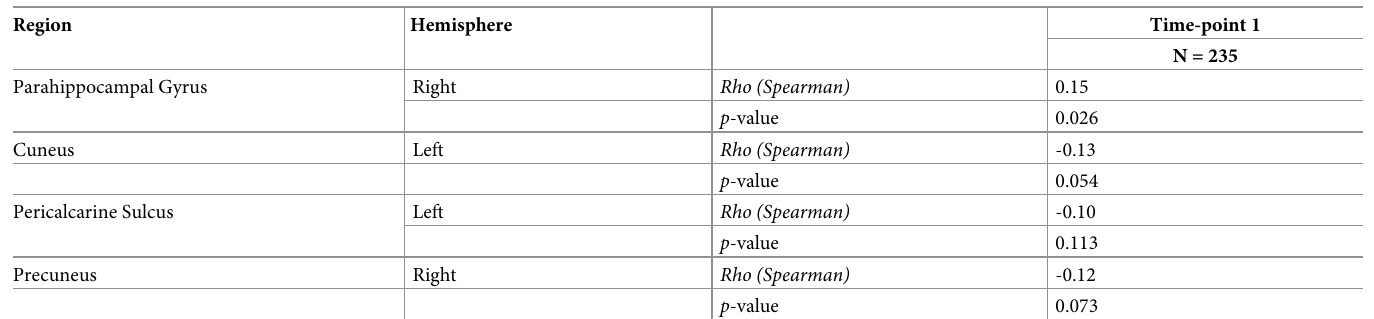
Table 2. Relationship between number of children and cortical thickness for